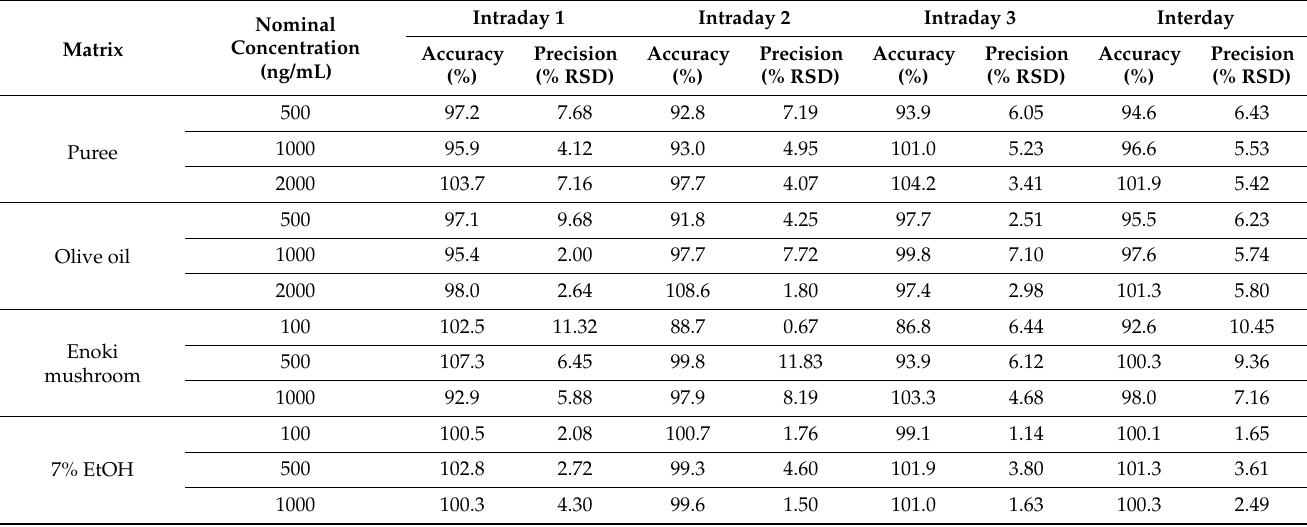
Table 3. Accuracy and precision for 4-n-NP in four food matrices ( n =